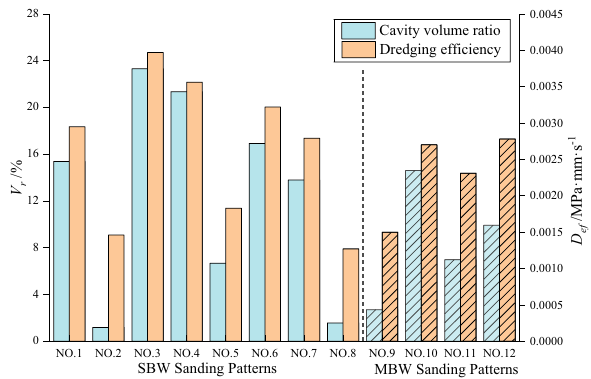
Fig. 13 Experimental results of cavity volume ratio and dredging effi- ciency of SBW and MBW sanding